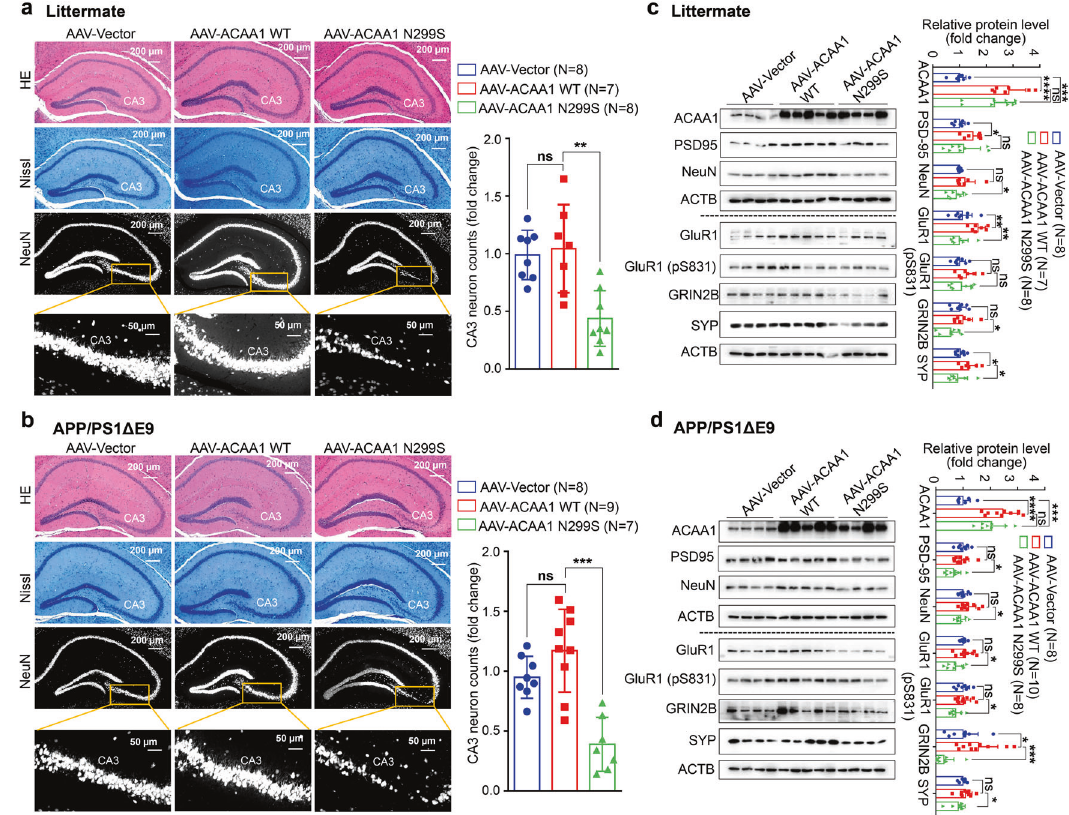
Fig. 5 Overexpression of ACAA1 p.N299S in APP/PS1 Δ E9 mice and WT littermates induced neuronal losses. a , b Neuronal loss in the CA3 region of hippocampus in WT littermates ( a ) and APP/PS1 Δ E9 mice ( b ) after delivery of the AAV-Vector, AAV-ACAA1 WT, and AAV-ACAA1 N299S. Higher neuronal density, marked by NeuN antibody, was noted in mice overexpressing ACAA1 p.N299S, suggesting a potential decrease of neurogenesis or an increase of neuron loss. Immunostaining of brain sections was performed using NeuN antibody. Shown results are representative hematoxylin and eosin (H&E) staining (top), Nissl staining (middle), and NeuN staining (bottom) of mouse hippocampus tissues in each group. c , d Decreased protein levels of structural plasticity markers SYP, PSD95, NeuN, GluR1, GluR1 (pS831), and GRIN2B in the hippocampus tissues of WT littermates ( c ) and APP/PS1 Δ E9 ( d ) mice with AAV-mediated expression of ACAA1 and its mutant. Bars represent mean ± SD. ns, not signi fi cant; * P < 0.05; ** P < 0.01; *** P < 0.001; **** P < 0.0001; Student ’ s t